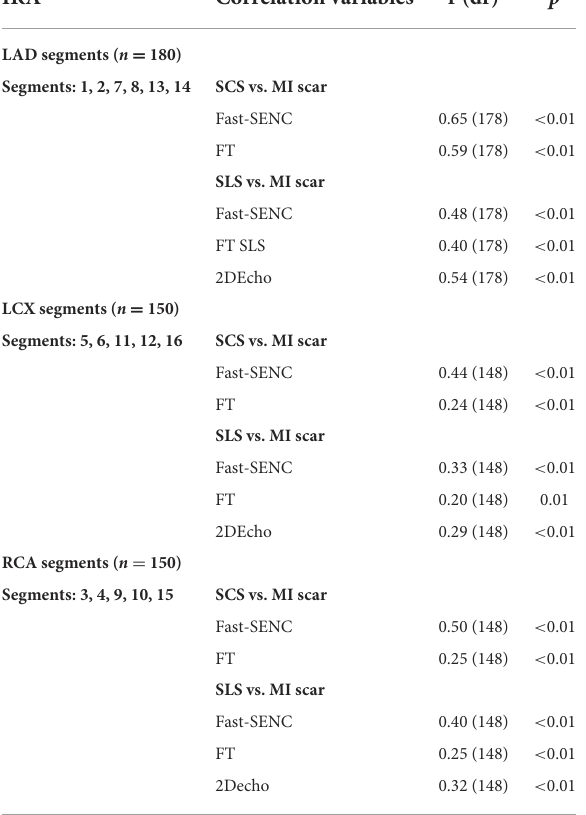
TABLE 5 Correlations of segmental